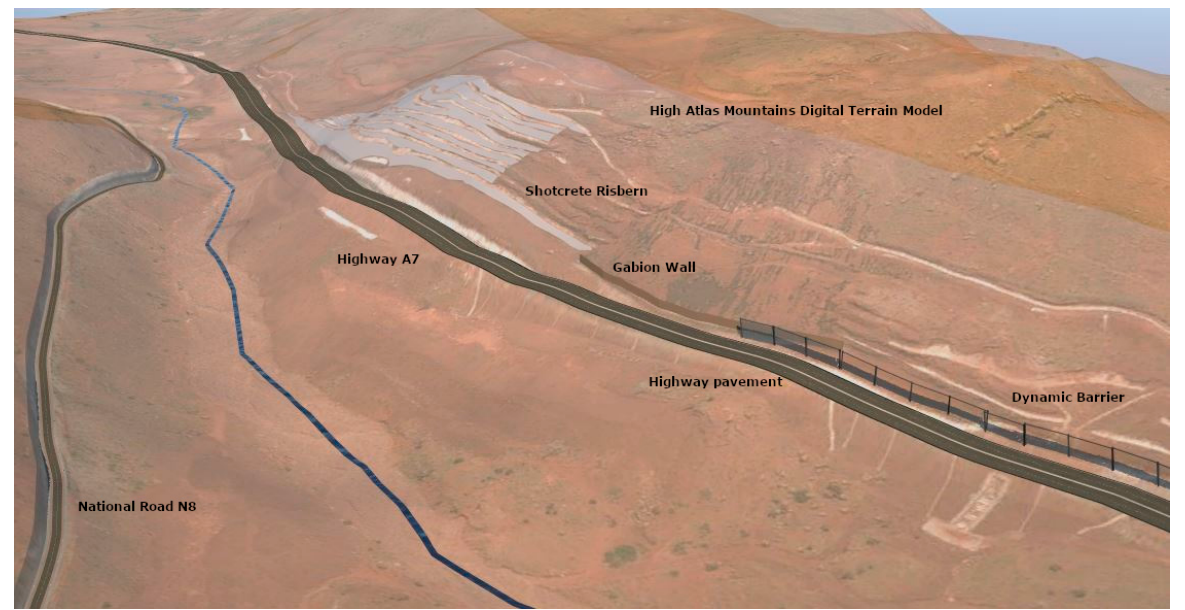
Figure 9. Highway 3D Model: studied segment of A7 Moroccan Highway (Infraworks software). Table 7. Examples of Operations Completed on the A7 Highway Slope.